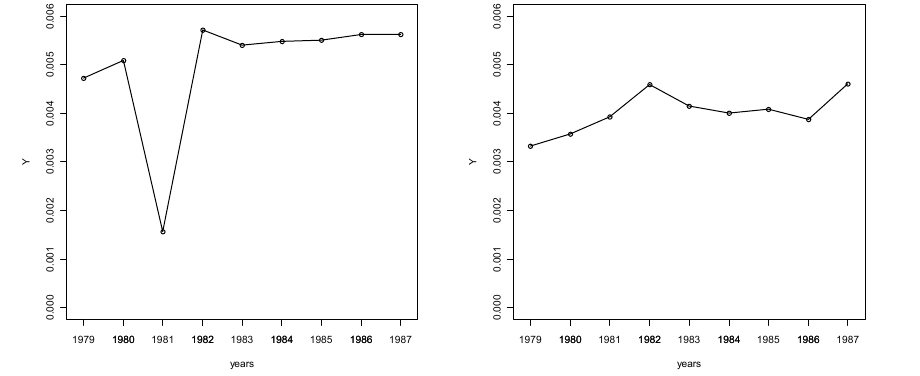
Figure 15 – Time series of municipality num- ber